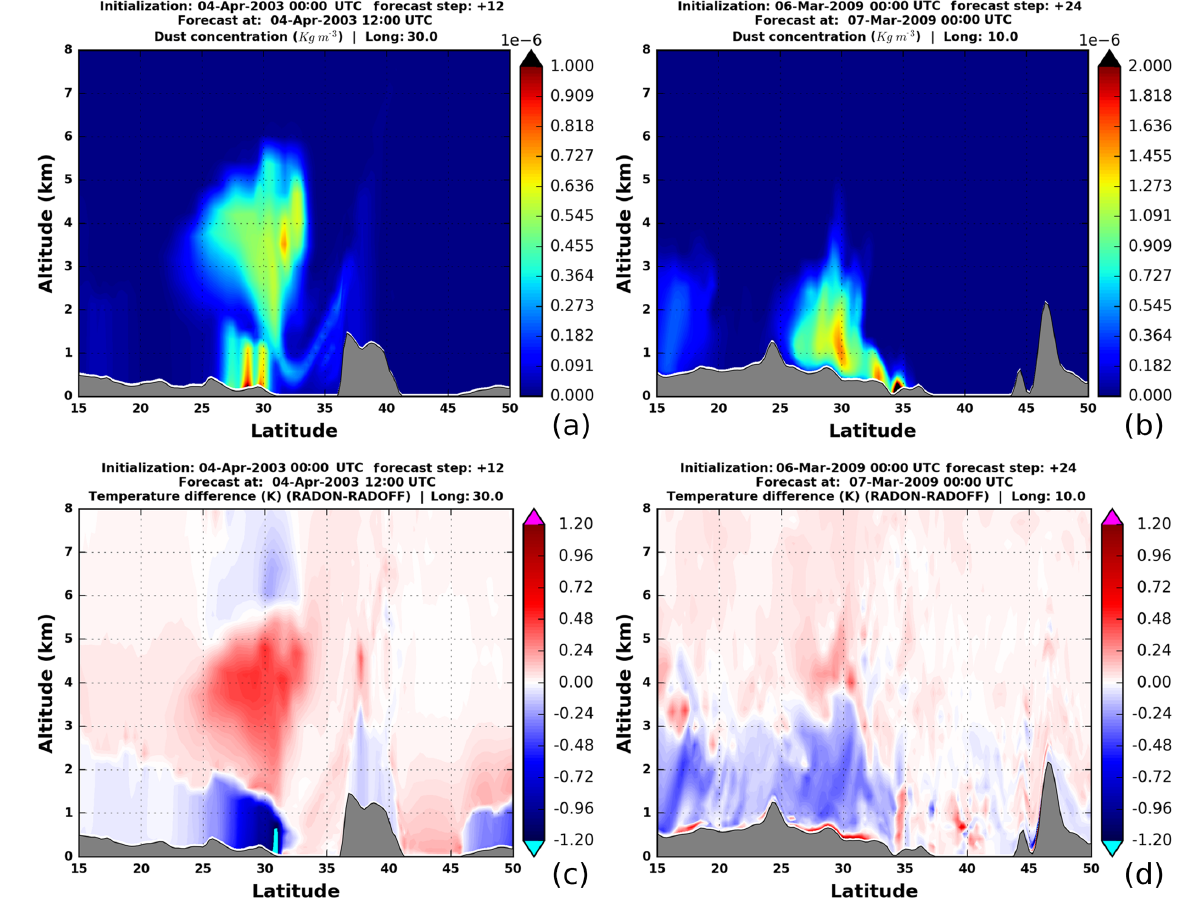
Figure 8. Altitude–latitude cross sections (up to 8kma.m.s.l.) simulated by the NMMB-MONARCH model of the (a, b) dust concentration (in kgm − 3 ) and (c, d) RADON-RADOFF temperature anomalies (in K) on (a, c) 4 April 2003 at 12:00UTC along the meridional 30 ◦ E and (b, d) 7 March 2009 00:00UTC along the meridional 10 ◦ E.